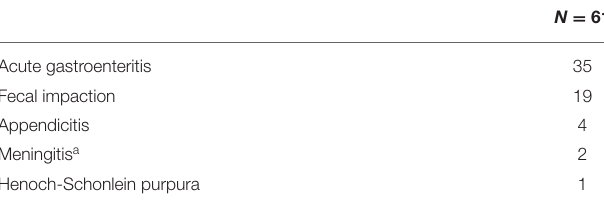
TABLE 4 | Initial assessment of patients in the undiagnosed